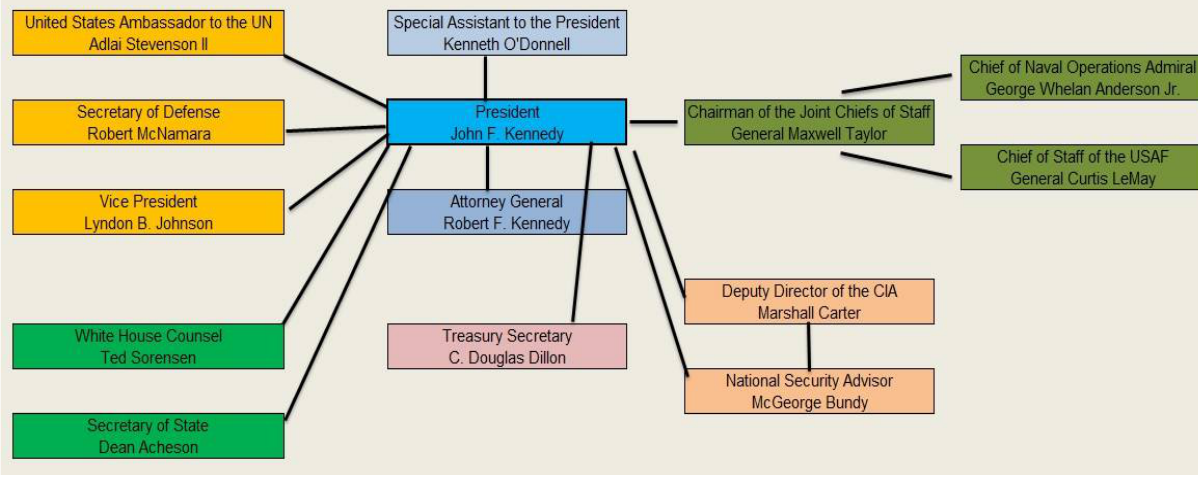
Figure 1 Kennedy Administration Small Groupthinking